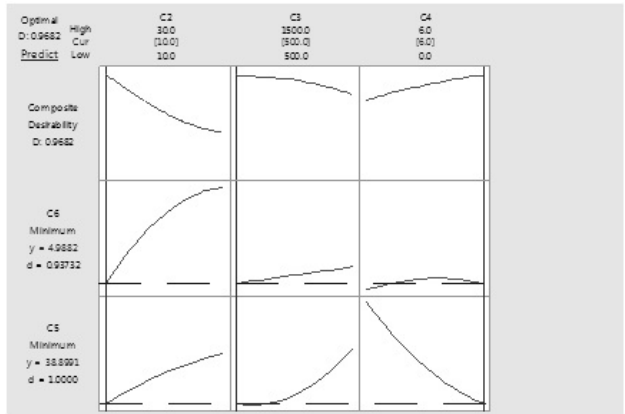
Figure 4. Desirability